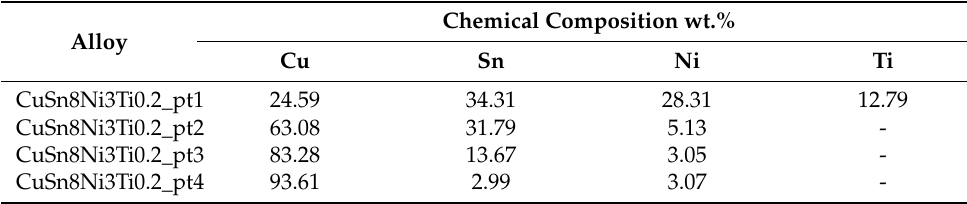
Table 6. Chemical composition EDS wt.% of CuSn8Ni3Ti0.2 alloy for the Figure 6c image.